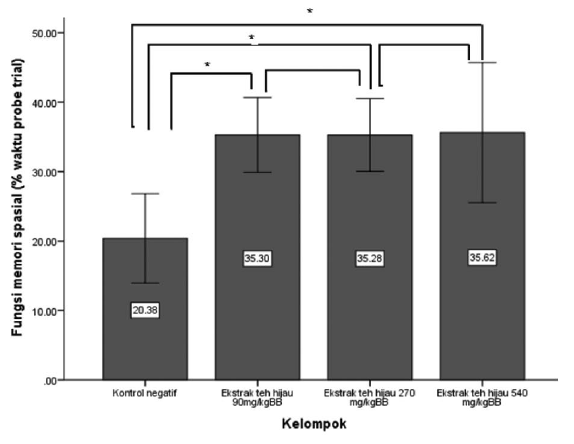
Figure 1. Comparison of mean travel time of mice in the phase of probe trial. Data are presented in mean (SD). * P